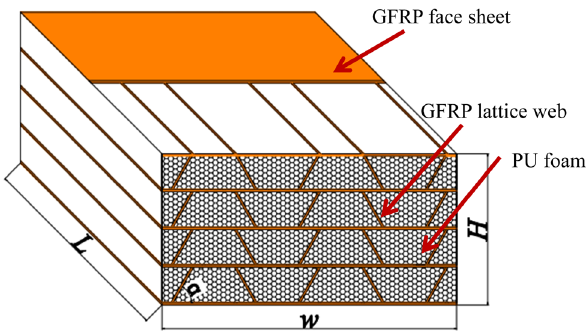
Figure 2: The novel foam - fi lled sandwich composite panels rein - forced by GFRP trapezoidal latticed